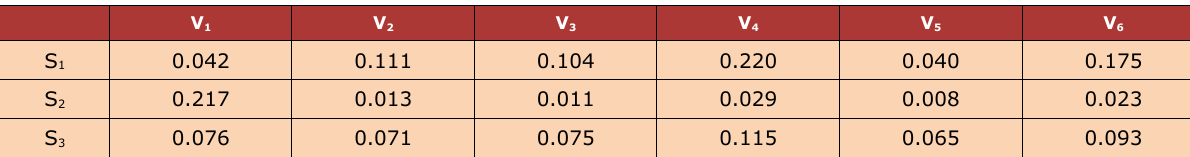
Table 7. Weighted and normalized decision